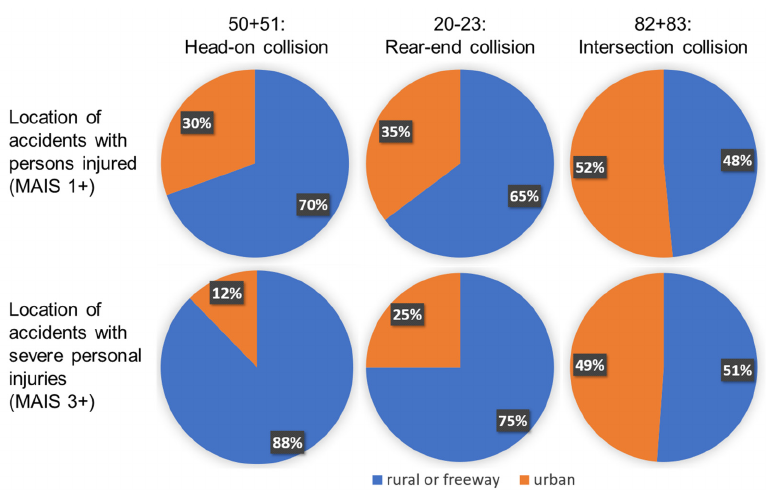
Figure 4. Locations of vehicle-to-vehicle accidents with slightly and seriously injured persons within the investigated scenarios.